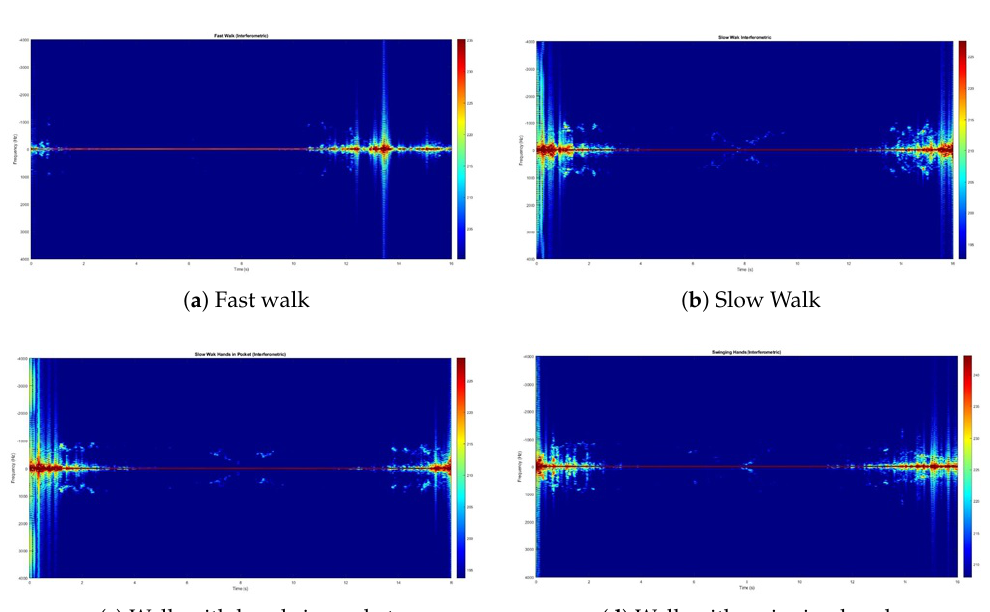
Figure 13. Doppler spectrogram (left to right).